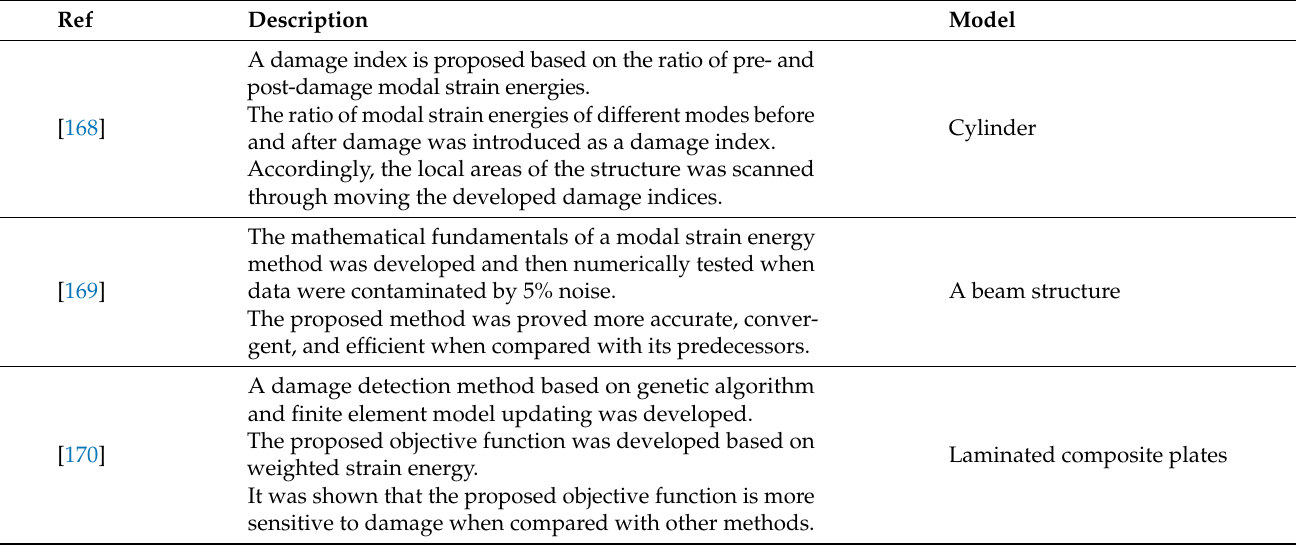
Table 12. Some recent developments in the application of modal strain energy in damage detection of composite